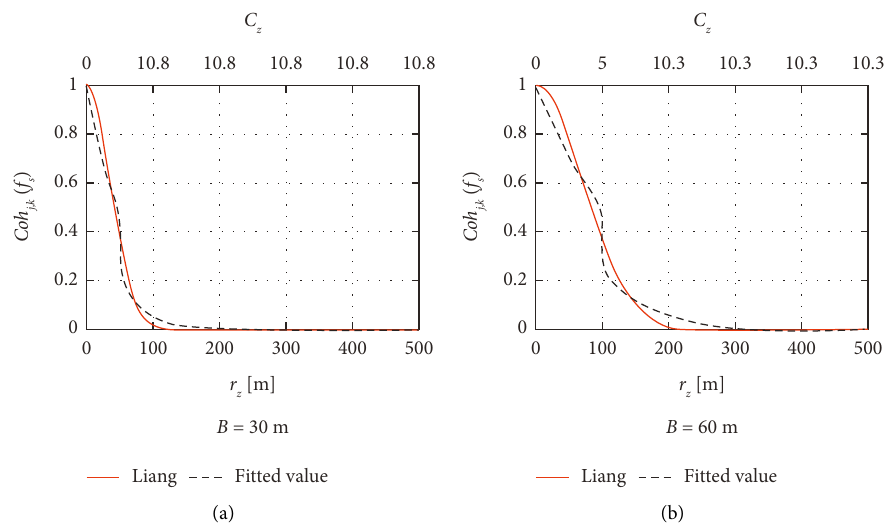
Figure 8: Vertical correlation at vortex shedding frequency for wind-induced torque: D/B � 1/4.